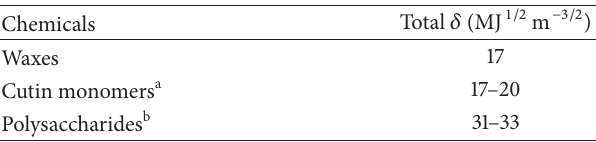
Table 2: Total solubility parameter ( 𝛿 ) of common model cuticular compounds